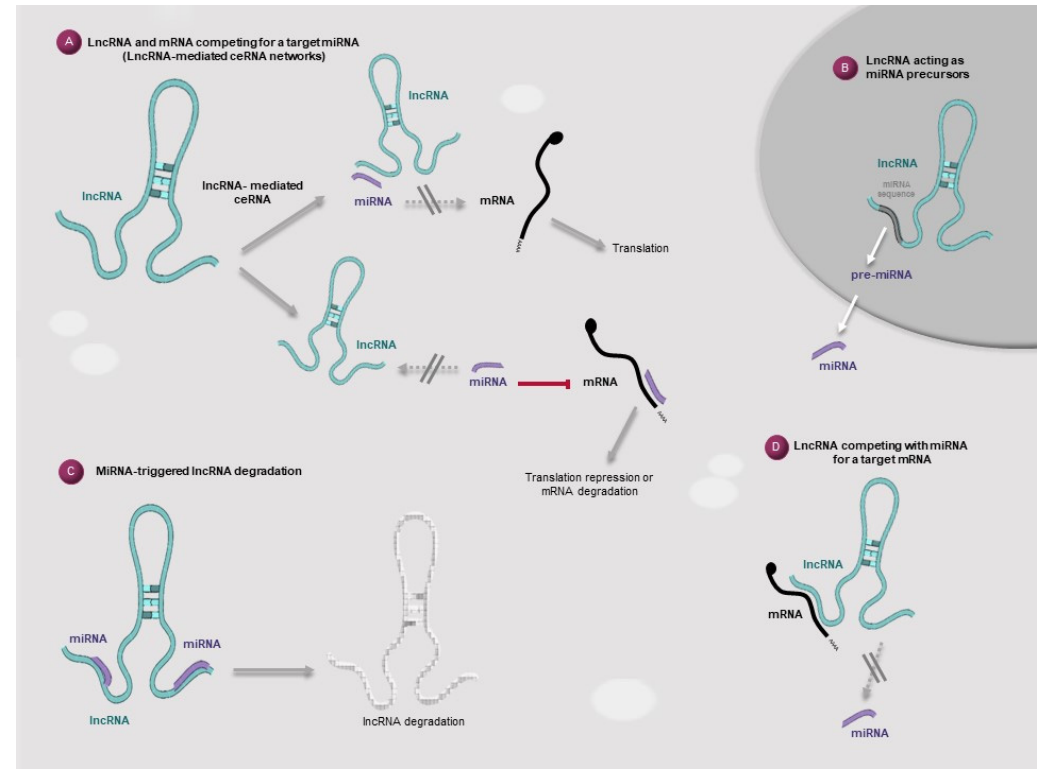
Figure 1. Cross-regulatory mechanisms involving lncRNAs and miRNAs. LncRNAs can act as ceRNAs, sponging miRNAs and obstructing their interaction with target mRNAs, consequently allowing for mRNA translation (upper A ); alternatively, the respective miRNA may bind to a target mRNA, inducing mRNA degradation or translation repression (lower A ). LncRNAs can be precursors of miRNAs as part of their biogenesis ( B ). MiRNAs can also decrease lncRNA stability through sequence-specific interaction, leading to lncRNA degradation ( C ). Finally, lncRNAs can compete with miRNAs for shared target mRNAs ( D ). (Image source: Mind the Graph).